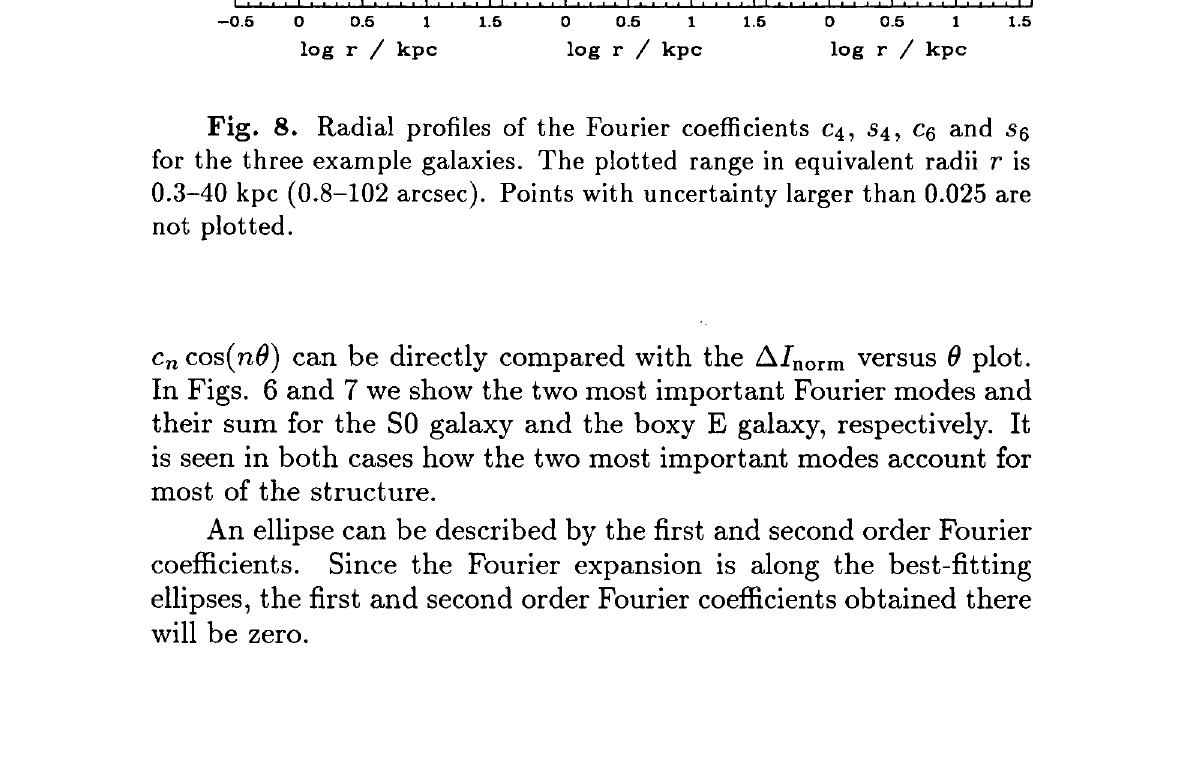
Fig. 8. Radial profiles of the Fourier coefficients C4, 54, CQ and for the three example galaxies. The plotted range in equivalent radii r is 0.3-40 kpc (0.8-102 arcsec). Points with uncertainty larger than 0.025 are not plotted.